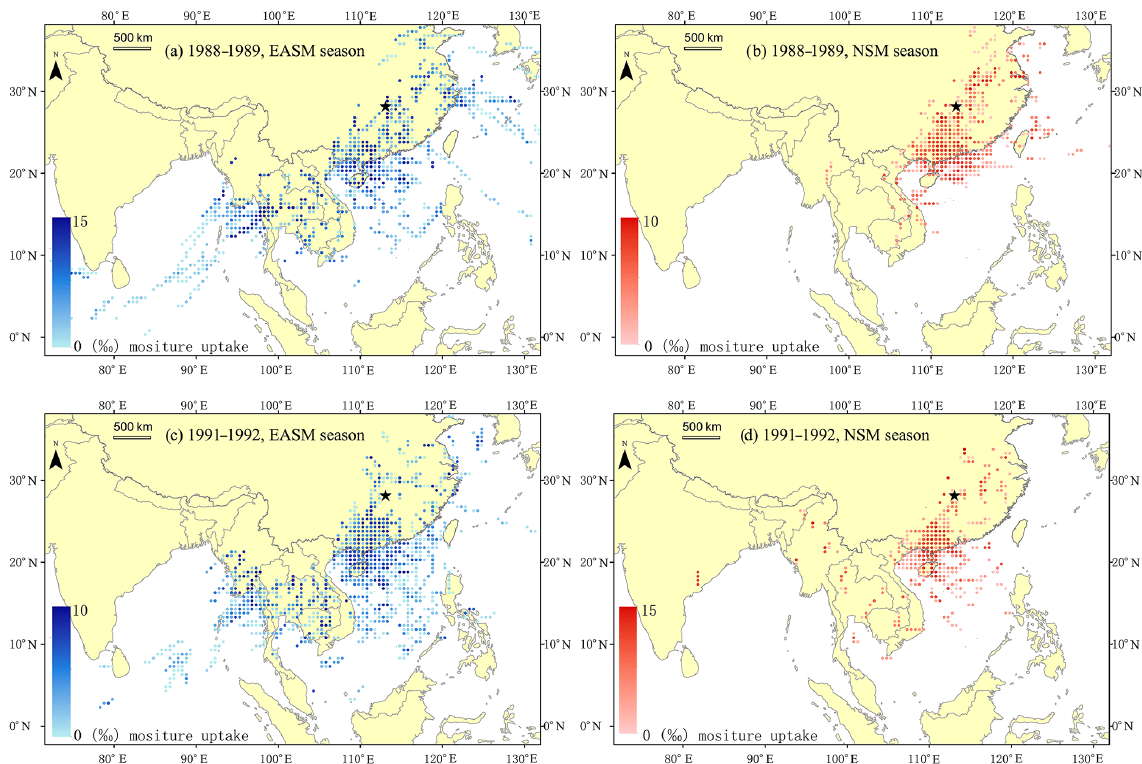
Figure 4. Seasonal distribution of moisture uptake contributing to Changsha precipitation in El Niño and La Niña years. Panels (a) and (b) show the moisture source uptake locations and their contribution to precipitation during EASM and NSM seasons in a La Niña phase (1988–1989), respectively; panels (c) and (d) are the same as (a) and (b) but for an El Niño phase (1991–1992). The black star indicates the Changsha GNIP